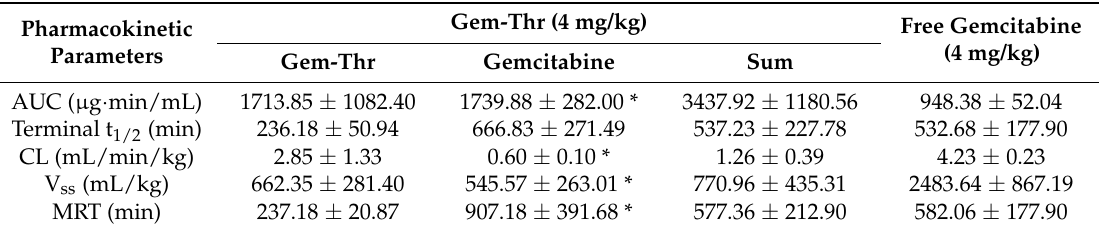
Table 1. Comparison of pharmacokinetic parameters of Gem-Thr, formed gemcitabine and sum of two species after intravenous administration of Gem-Thr at a dose of 4 mg/kg with those of free gemcitabine alone at a dose of 4 mg/kg in rats ( n = 3–4).